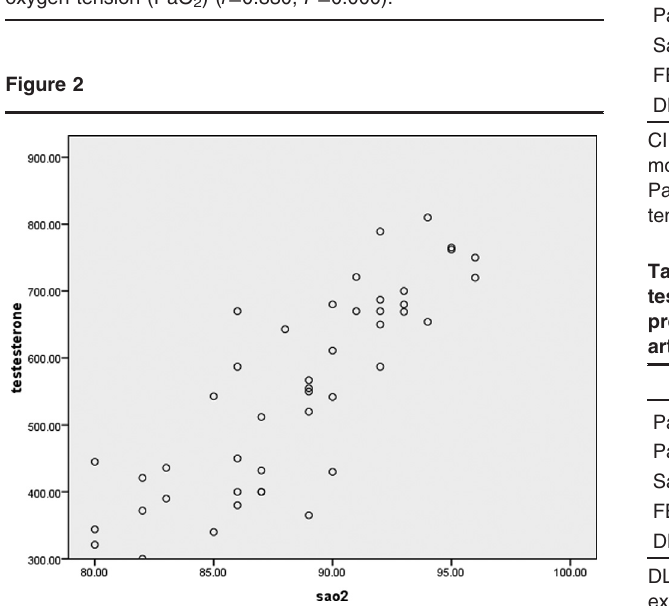
Positive correlation between total testosterone level and arterial oxygen saturation (SaO 2 ) ( r = 0.835; P = 0.000).